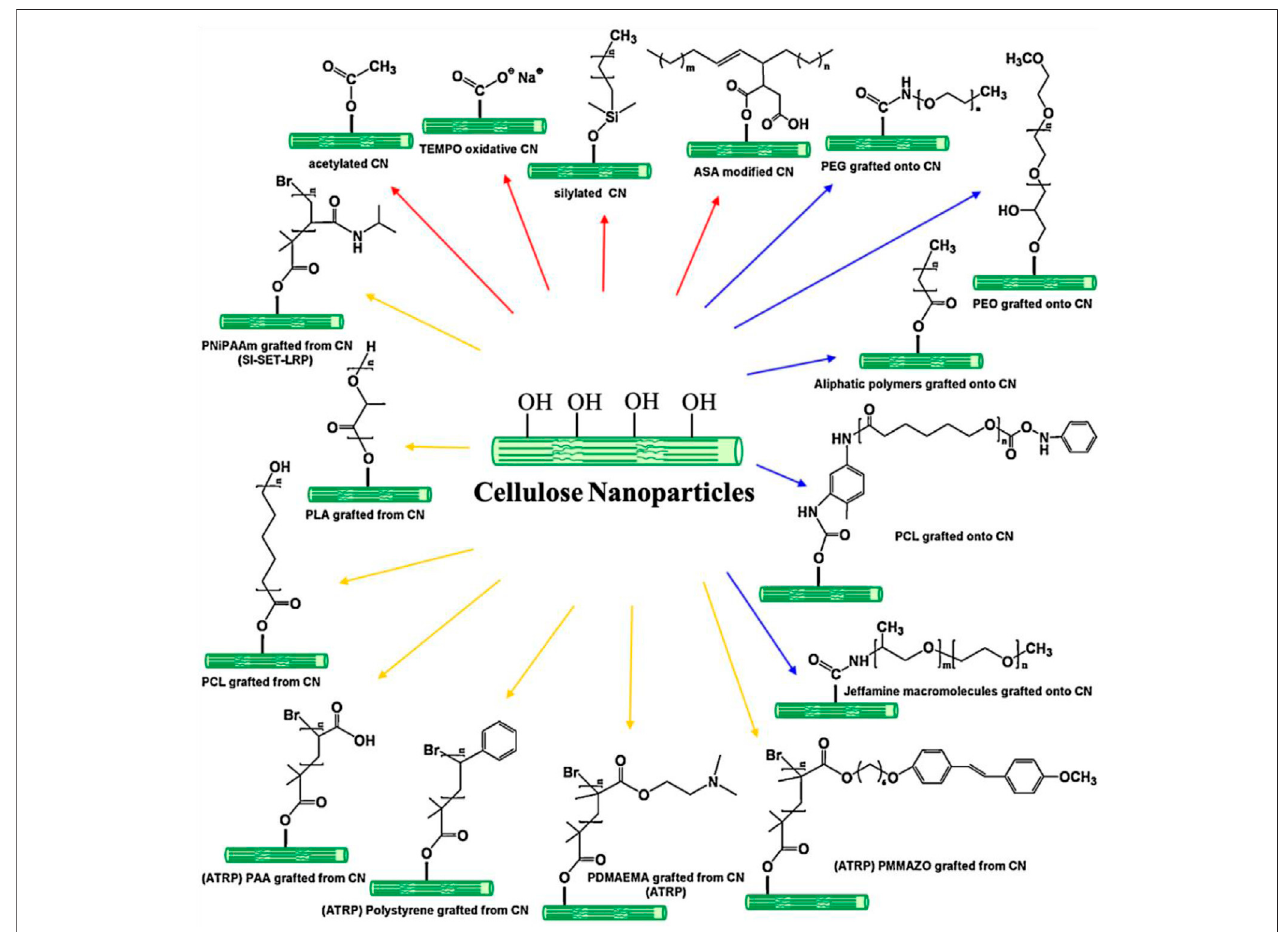
FIGURE 9 | Various chemical grafting methods for surface modi fi cation of cellulose nanoparticles (CNs). Adapted from Dufresne (2013)